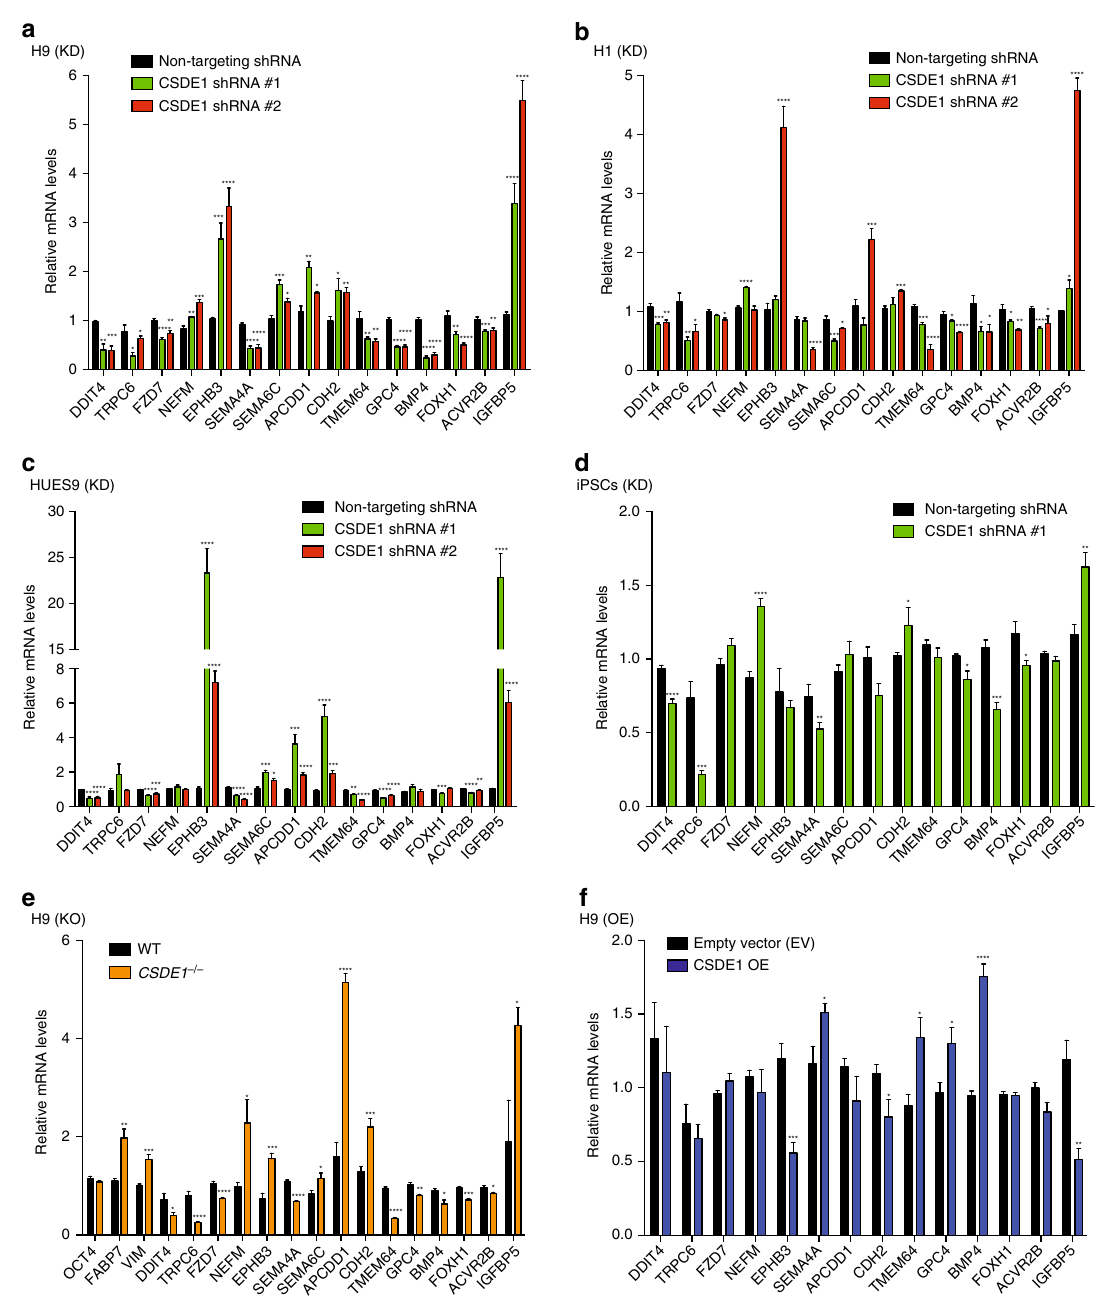
Fig. 9 CSDE1 regulates the steady-state mRNA levels of neural factors in multiple pluripotent cell lines. a – d qPCR analysis of distinct CSDE1 KD hESC and iPSC lines daily monitored to remove differentiated cells. Graphs (relative expression to non-targeting (NT) shRNA) represent the mean ± s.e.m. a H9 hESCs, n = twelve biological replicates from fi ve independent experiments; b H1 hESCs, n = six biological replicates from two independent experiments; c HUES9 hESCs, n = nine biological replicates from two independent experiments; d iPSCs, n = six biological replicates from two independent experiments. e qPCR analysis of CSDE1 − / − H9 hESCs daily monitored to remove differentiated cells. Graph (relative expression to wild-type H9 hESCs) represents the mean ± s.e.m of six biological replicates from two independent experiments. f qPCR analysis (relative expression to EV H9 hESCs) in CSDE1 OE hESCs. Data represent two independent experiments with three biological replicates. KD = CSDE1 knockdown. KO = CSDE1 knockout. OE = CSDE1 overexpression. All the statistical comparisons were made by Student ’ s t -test for unpaired samples. P -value: *( P < 0.05), **( P < 0.01), ***( P < 0.001), **** ( P < When cultured in serum and leukemia inhibitory factor (LIF), mESCs are in a naive state resembling the pluripotent state observed in the inner cell mass of the pre-implantation embryo 33 . As such, mESC cultures are heterogeneous and consist of at least two morphologically indistinguishable cell types, resembling either primitive endoderm lineages or primed progenitors of the epiblast 52 . On the other hand, hESCs are markedly different